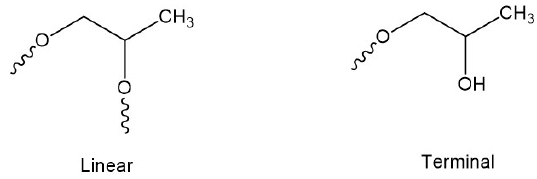
Figure 4. Representation units of PC monomers